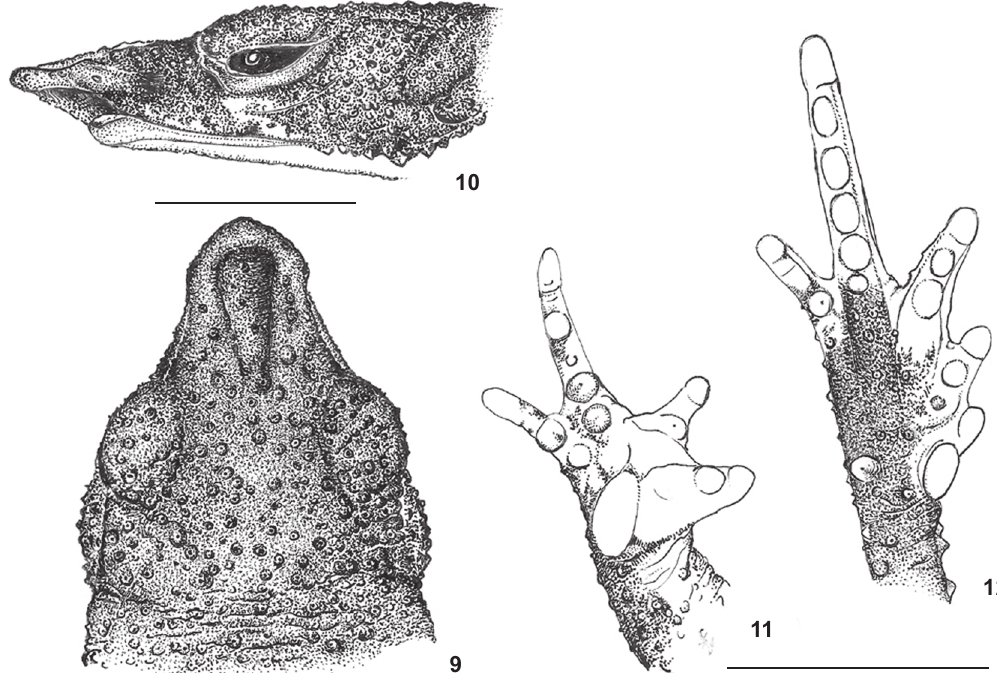
Figures 9-12. Rhinella skuki sp. nov. , holotype, MNRJ 74619, SVL 26.2 mm: (9) dorsal view of head; (10) lateral view of head: (11) hand; (12) foot. Scale bars: 5